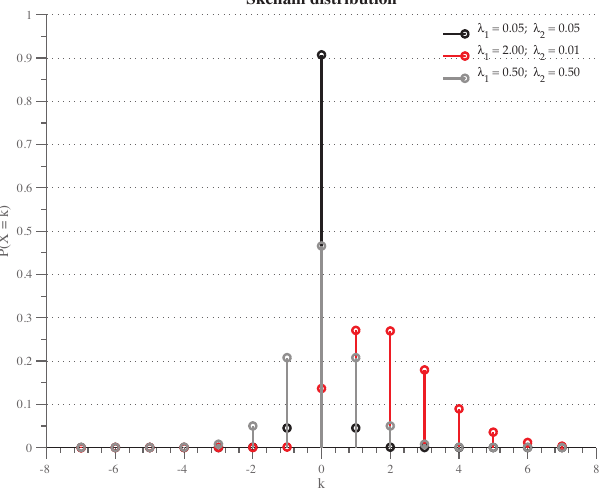
Fig. A1. Skellam probability mass functions for different values of its parameters λ 1 and λ 2